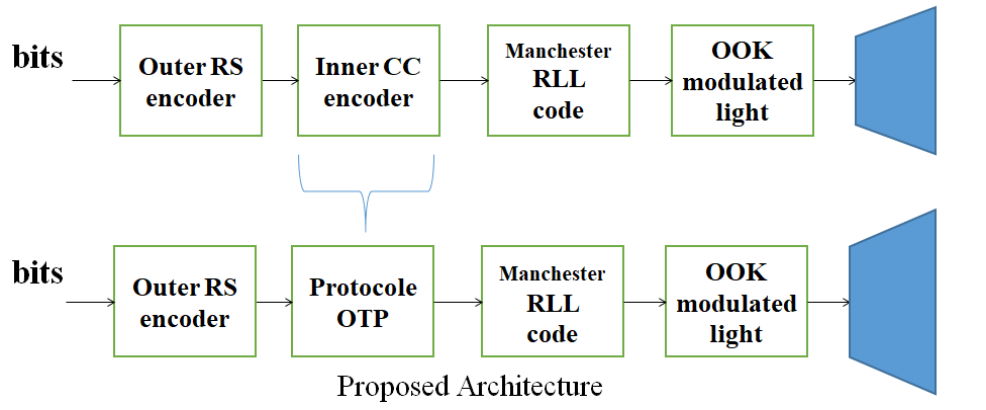
Figure 2. OOK transmitter block diagram.